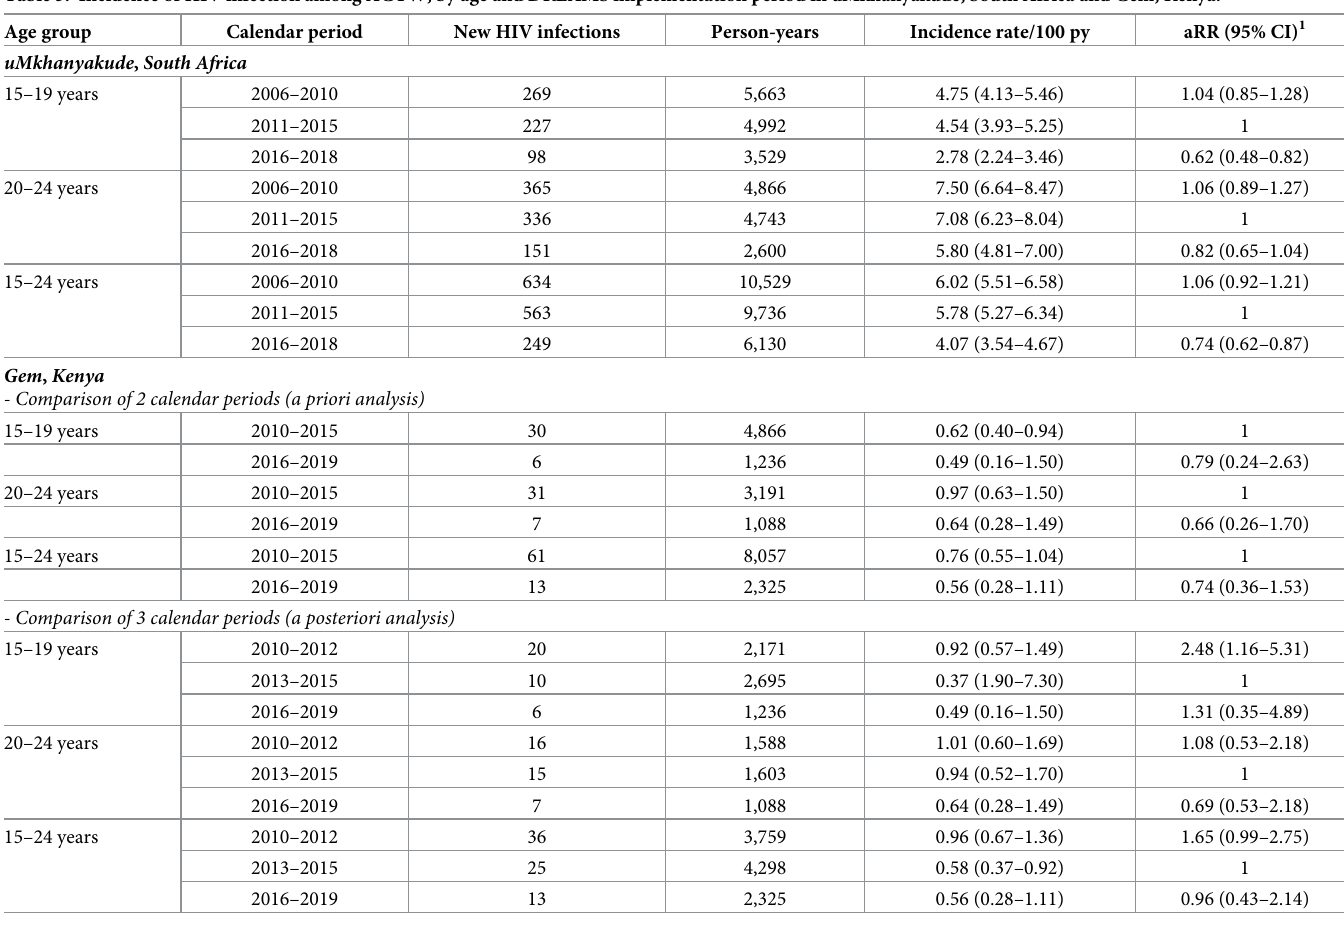
Table 3. Incidence of HIV infection among AGYW, by age and DREAMS implementation period in uMkhanyakude, South Africa and Gem, Kenya. Age